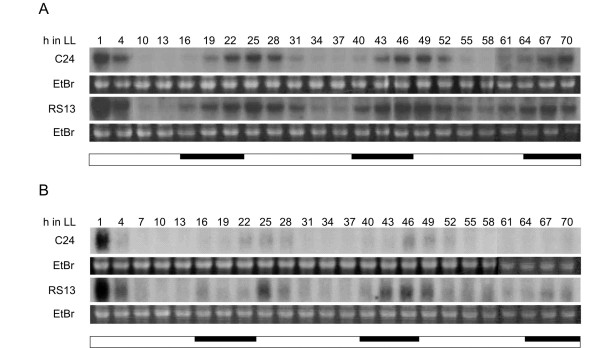
Influence of AtGRP7 overexpression on rhythmic target transcripts. C24 wt and the AtGRP7-ox plants RS13 were grown in long days for two weeks, transferred to continuous light and harvested at 3-h intervals for three days. The RNA gel blots were hybridized with an STH probe (A) and an HYH probe (B). A representative northern blot of two independent time courses is shown. The ethidium bromide-stained agarose gel is shown to confirm equal loading. The inserted dark bar indicates subjective night.